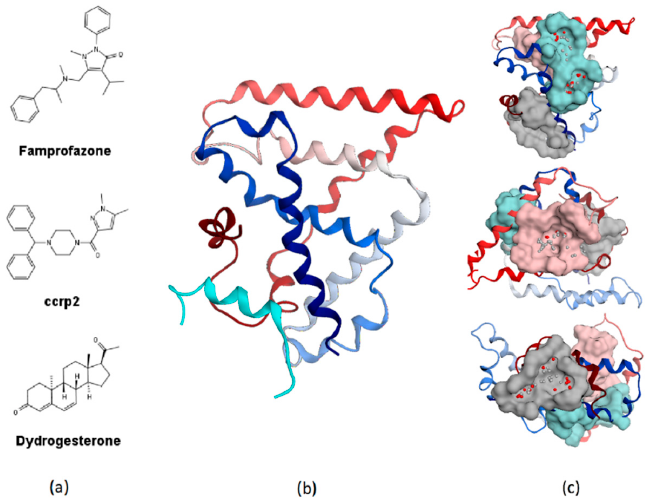
Figure 1. ( a ) Structures of small molecule ligands of TLX, found by medium-throughput screening [30]; ( b ) Structure of TLX LBD in complex with Atro-box peptide (PDB ID 4XAJ) in ribbon representation. TLX is colored from blue for N-terminus to red for C-terminus; Atro-box peptide is colored cyan. ( c ) Surfaces of the pockets in the TLX LBD regions potentially important for transcriptional function: cyan—the region of H1 helix packing, pink—the homodimerization region, grey—Atro-box binding pocket. Spheres represent calculated alpha-spheres that contact 4 protein atoms on its boundary and contains no internal atoms [33].